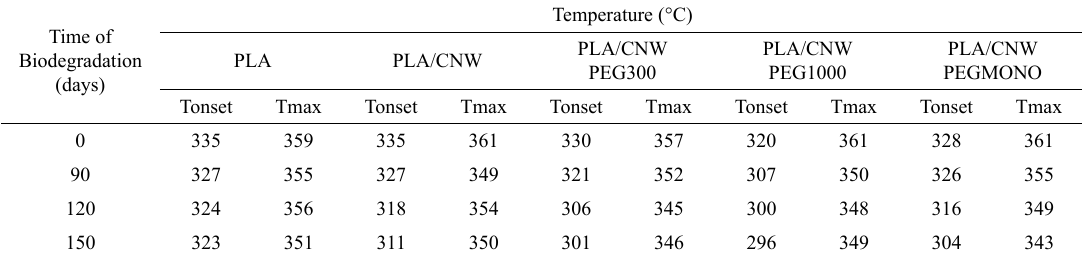
Table 1. Values of the onset degradation temperature (Tonset) and temperature at the maximum rate of weight loss (Tmax) for neat PLA, PLA/CNW and PLA/CNW/S nanocomposites at different exposure times in